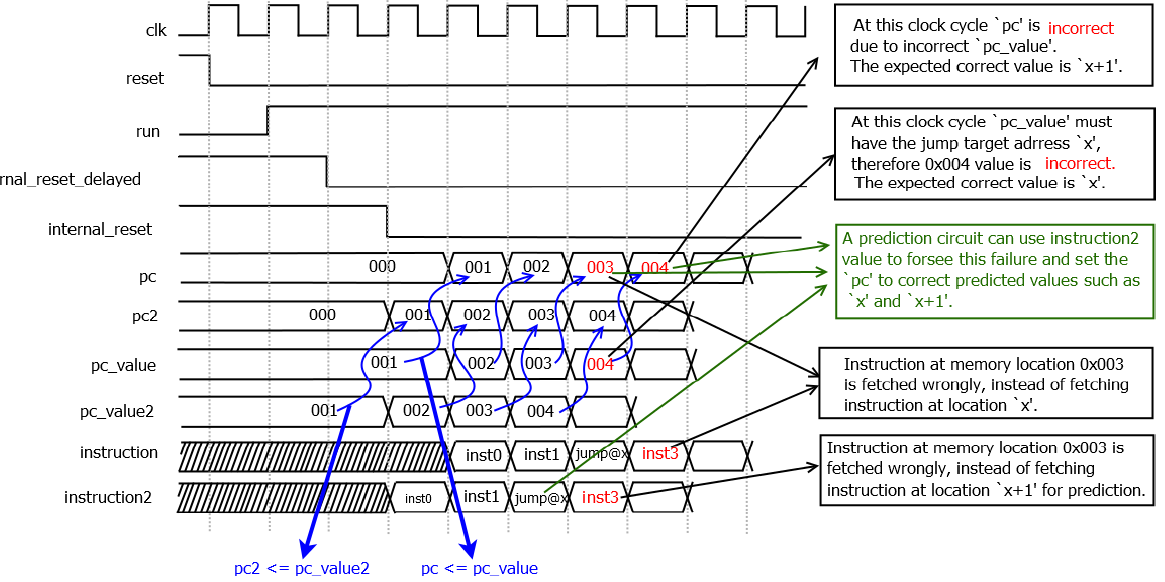
Figure 9. Elaboration of Zipi8 instruction fetch failure after its modifications to achieve CPI = 1 and before adding a branch prediction circuit.